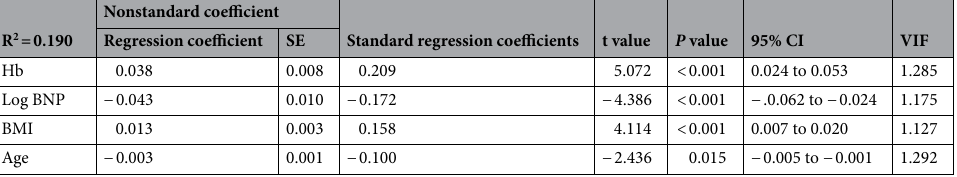
Table 6. Results of the multiple regression analysis to identify the clinical factors influencing FT3 (n = 625). FT3, free triiodothyronine; R 2 , adjusted coefficient of determination; CI, confidence interval; VIF, variance inflation factor; Hb, hemoglobin; BNP, B-type natriuretic peptide; BMI, body mass index.